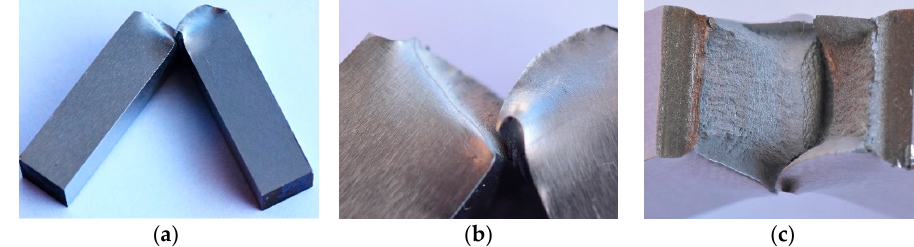
Figure 6. V-notched specimens of the parent material and weld of S700MC steel after Charpy test: ( a )—specimen after test; ( b , c )—fracture zone from side and top view, respectively.